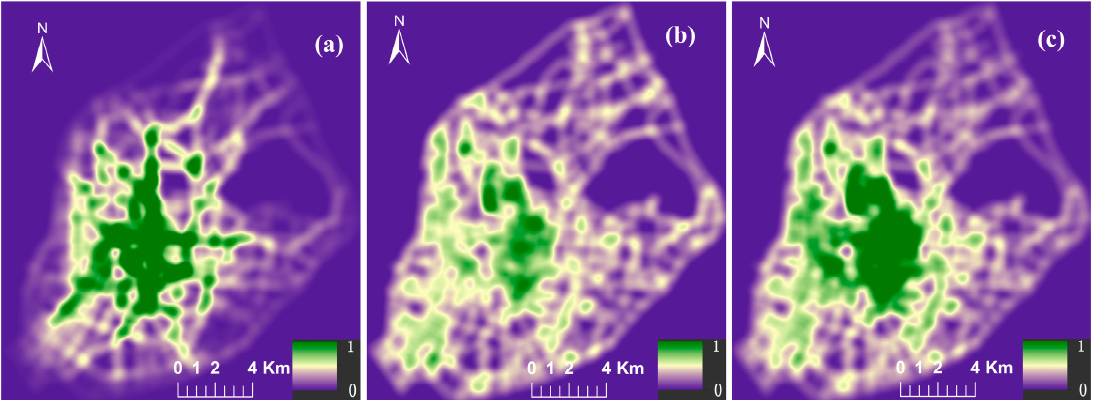
Figure 8. ( a ) KDE of street betweenness; ( b ) straightness; and ( c ) closeness centrality in main urban areas.